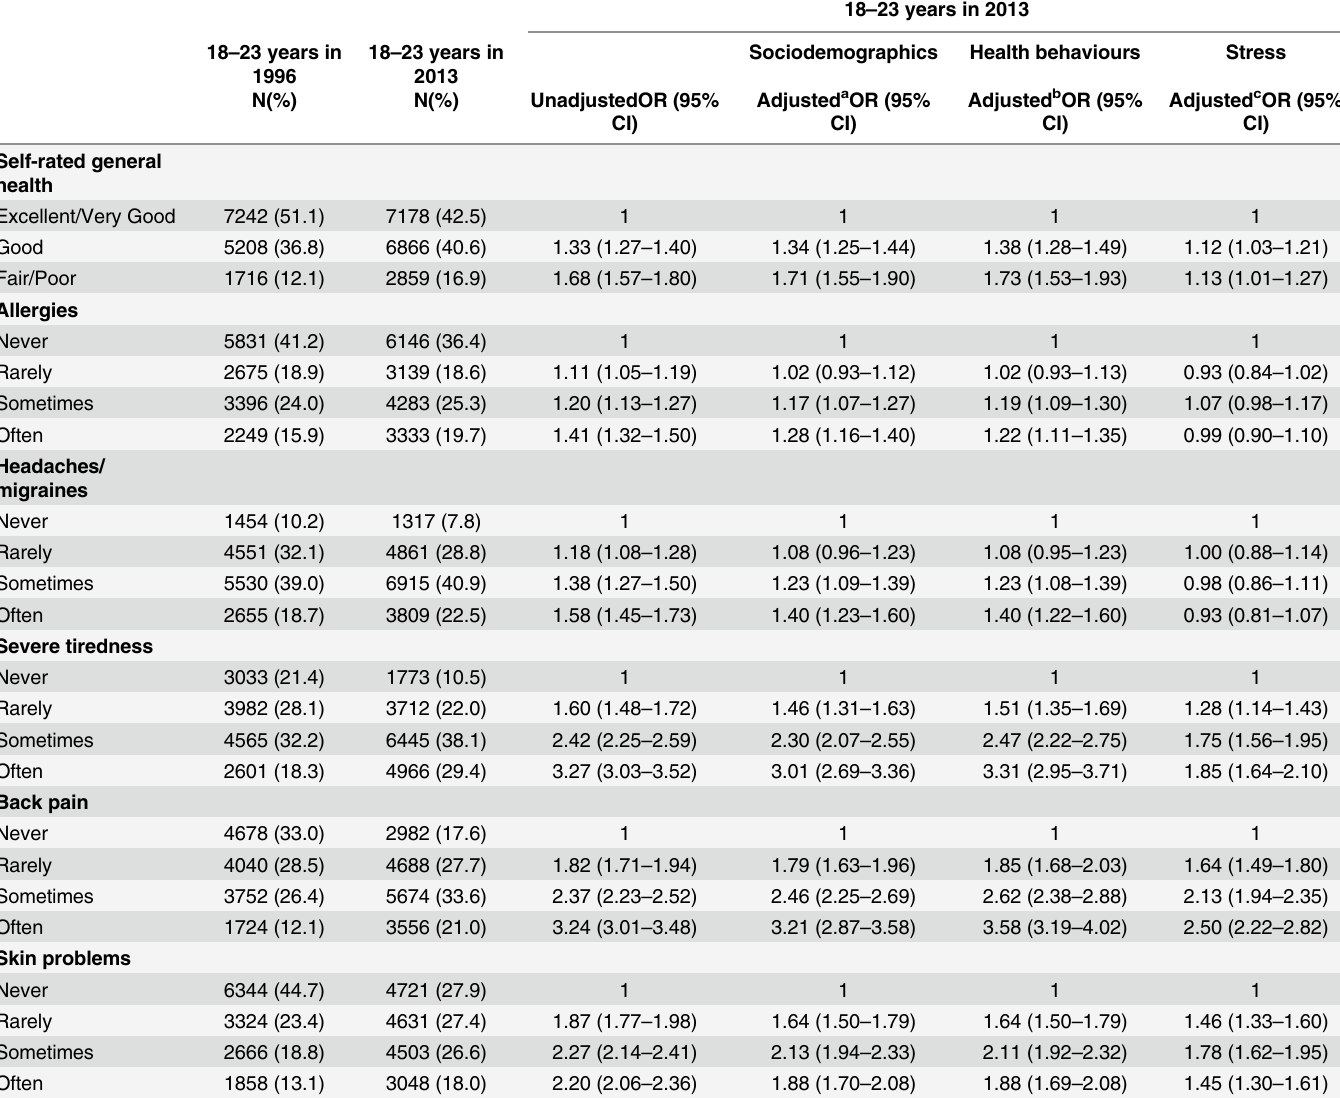
Table 2. Comparisons of somatic symptoms between two cohorts of young women aged 18 to 23 years in 1996 and in 2013. Odds ratios for partici- pants in 2013 compared to participants in